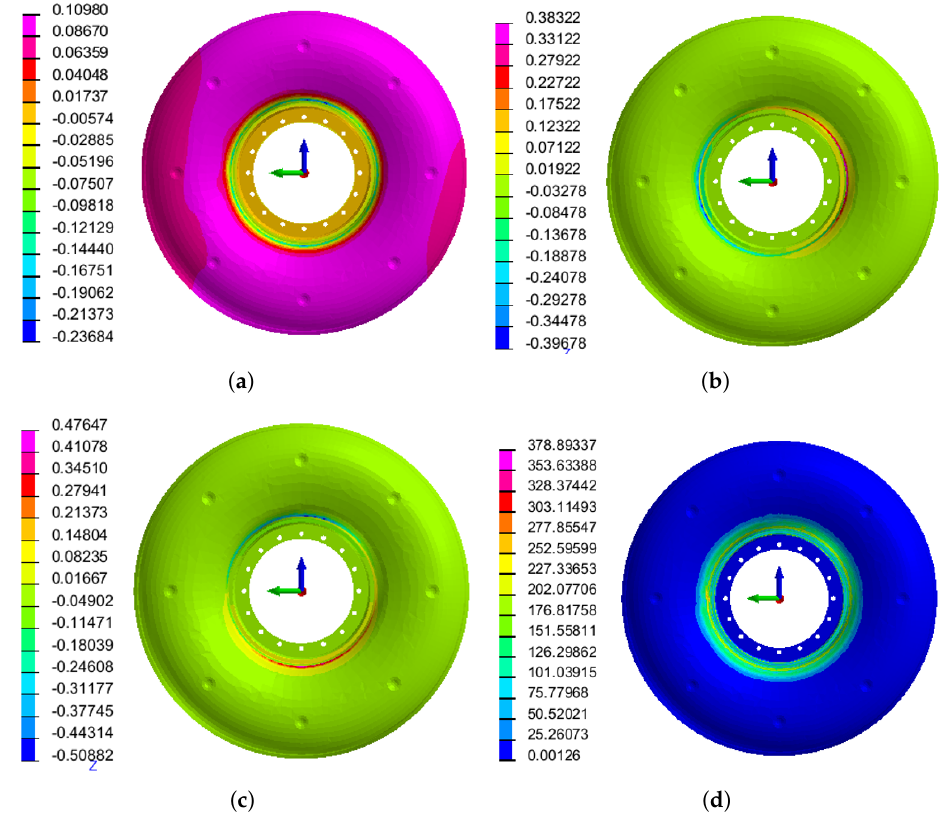
Figure 11. Simulation results (a) Axial deformation (b) radial deformation(Y-axis) (c) radial deformation(Z-axis) (d) Residual Stress